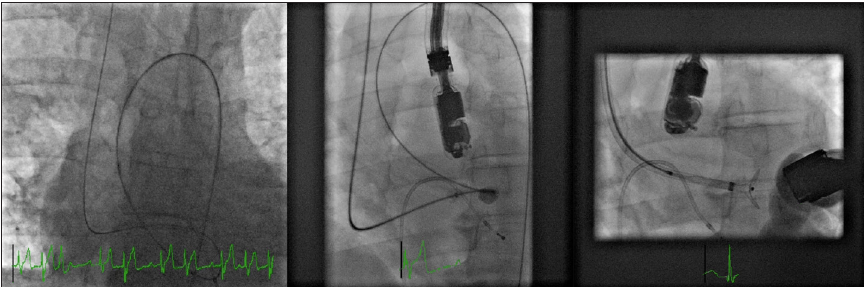
Figure 2. (left) Fluoroscopic image demonstrates a glidewire loop which crosses and snares the VSD, then externalizes to the right internal jugular vein. Middle: balloon sizing of the VSD. Right: the closure of the VSD with 16 mm Amplatzer VSD occluder.